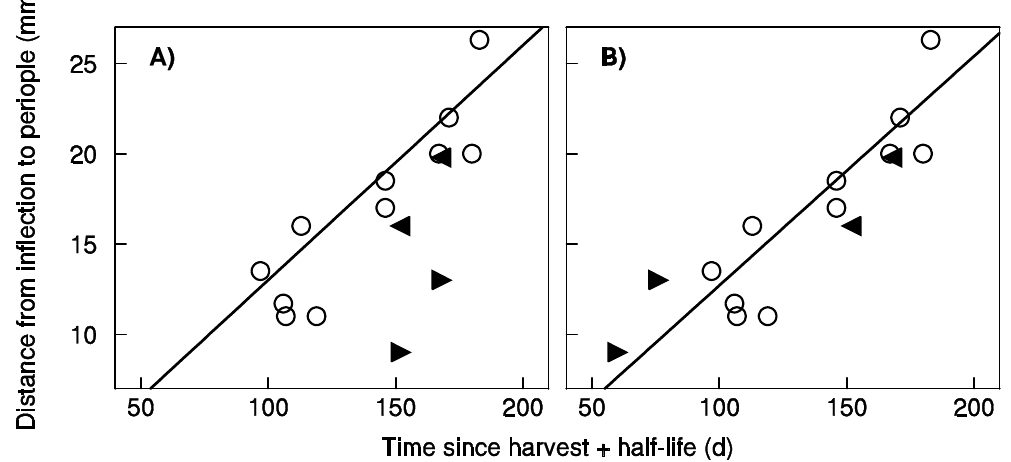
Figure 3. Distance between the inflection point and the periople depending on the time since the maize harvest plus one half-life at the date of hunting. In ( A ) only the animals with one clear peak (open circles) were used to calculate mean growth rate (0.130 mm/day; line); In ( B ) also the more distant peaks (left-tipped triangles) of the two animals with two peaks were used to calculate growth rate (0.122 mm/day). The peaks closer to the periople (right-tipped triangles) were assumed to result from winter feed provision. They are plotted at a position which would result if winter feed provision ended in early February, but were not included in the calculation of mean growth rate.